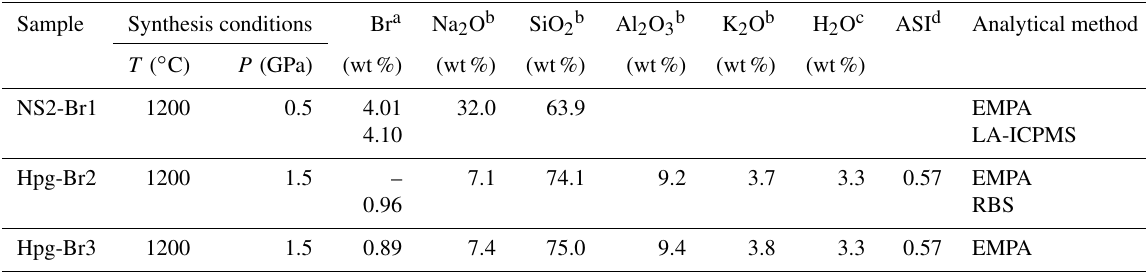
Table 1. Synthesis conditions and chemical compositions of the Na 2 Si 2 O 5 (NS2) and haplogranite (Hpg) glasses employed as starting materials in this